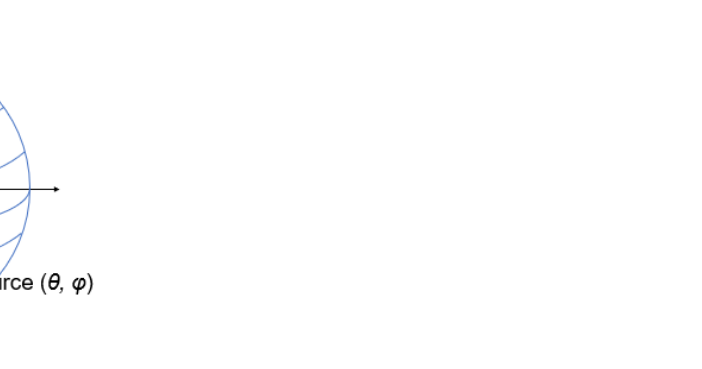
Figure 2. Illustration of the geometrical setup of the imaging problem.